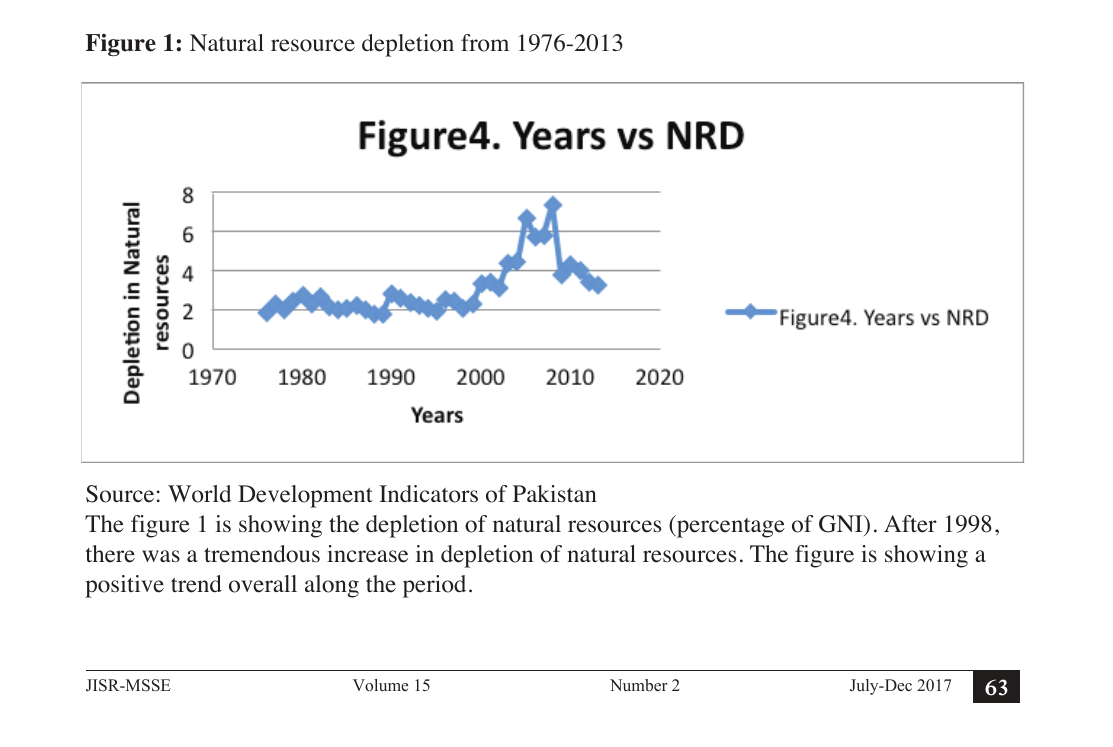
Figure 1: Natural resource depletion from 1976-2013